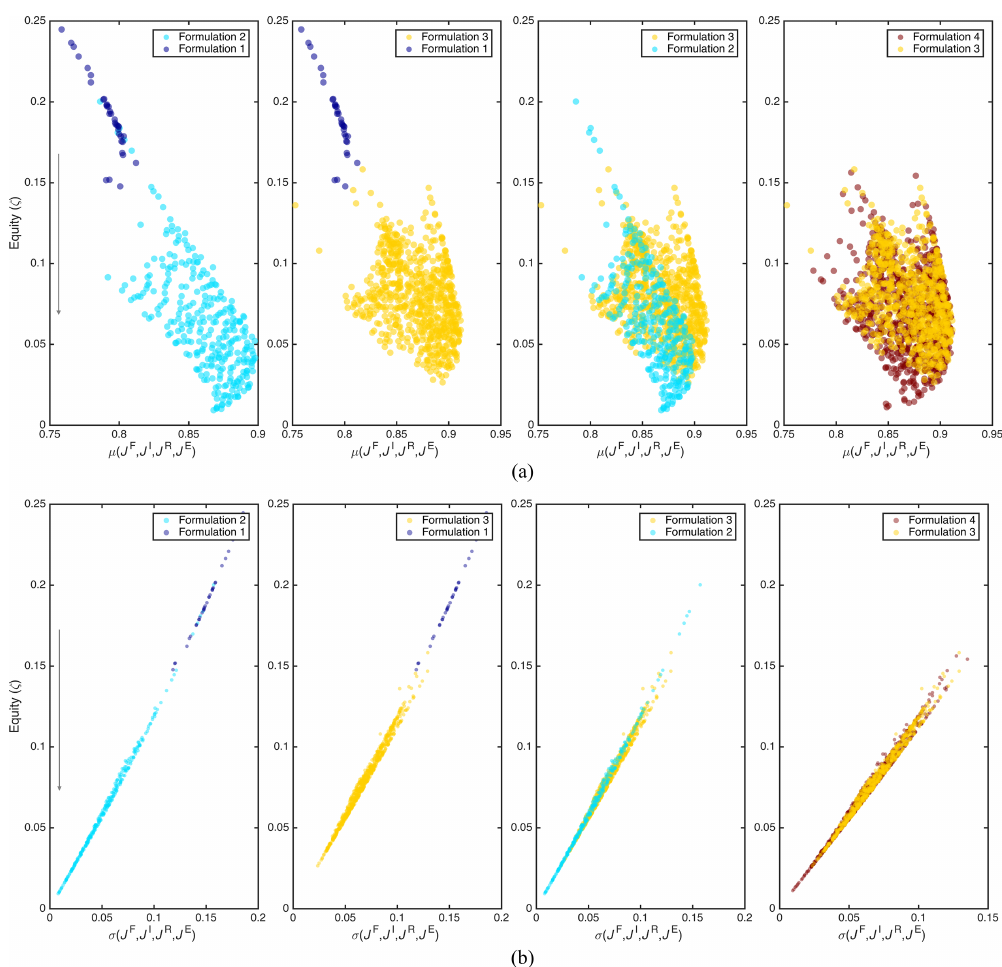
Figure 6. Comparisons of the relationship between the equity index and (a) mean µ and (b) standard derivation σ of J F , J I , J R , and J E for solutions from problems F1–F4. Each dot in the scatterplots represents one optimal solution. Solutions with a lower equity index ζ and higher performance mean value µ ( J F , J I , J R , J E ) are generally preferable. The arrow on the y axis shows the direction of preference.